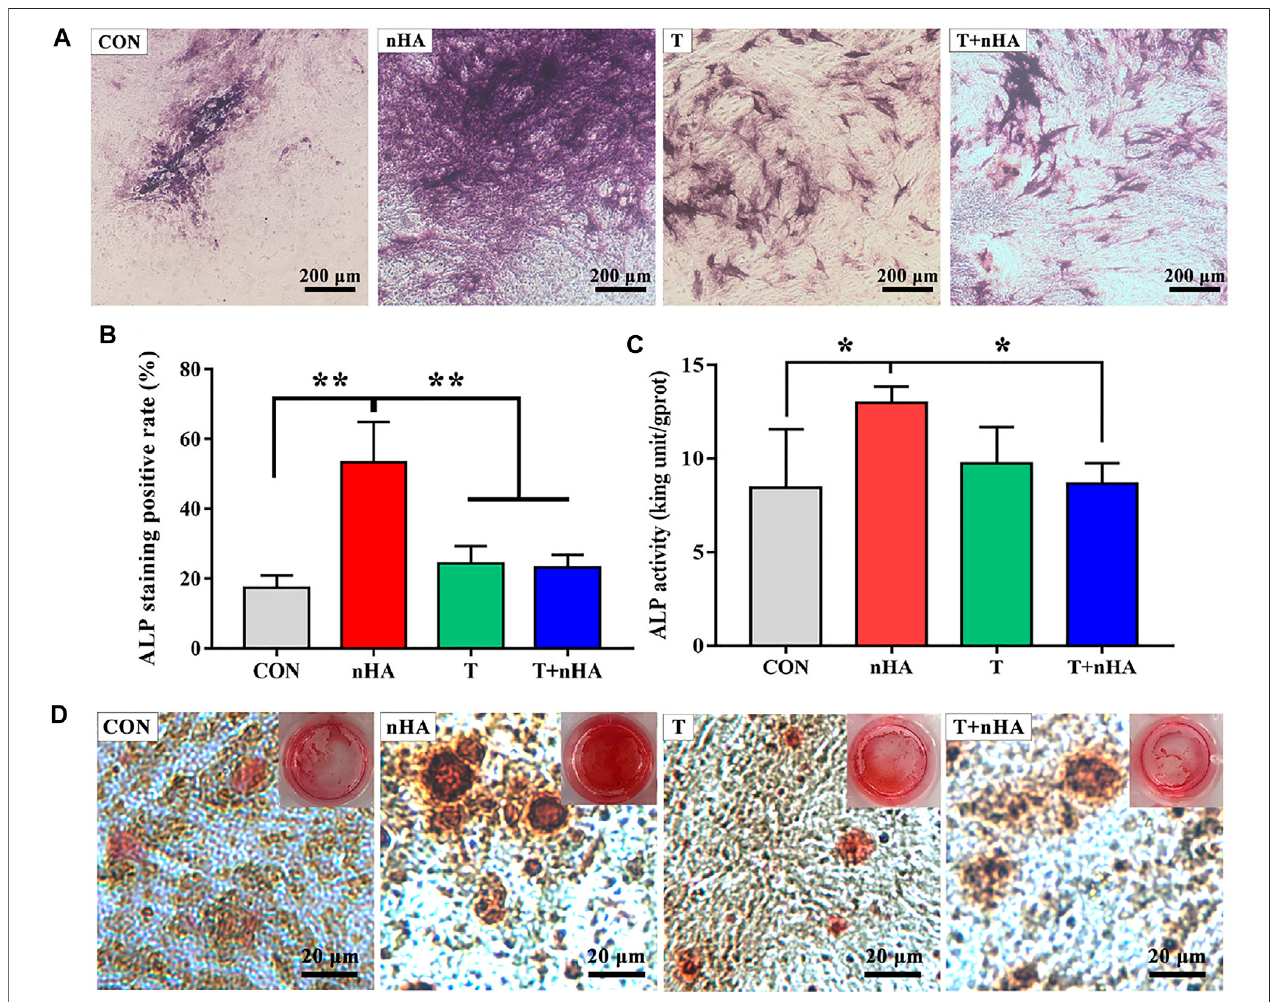
FIGURE6 | (A) ALP stainingimages. (B) The quantitative assessmentof the ALP staining results wasperformed using ImageJ. (C) ALP activity of MC3T3-E1 cells on different samples after 14 days of culture. * represents p < 0.05 and ** represents p < 0.01. (D) ARS stained images of MC3T3-E1 cells on different samples after 14 days